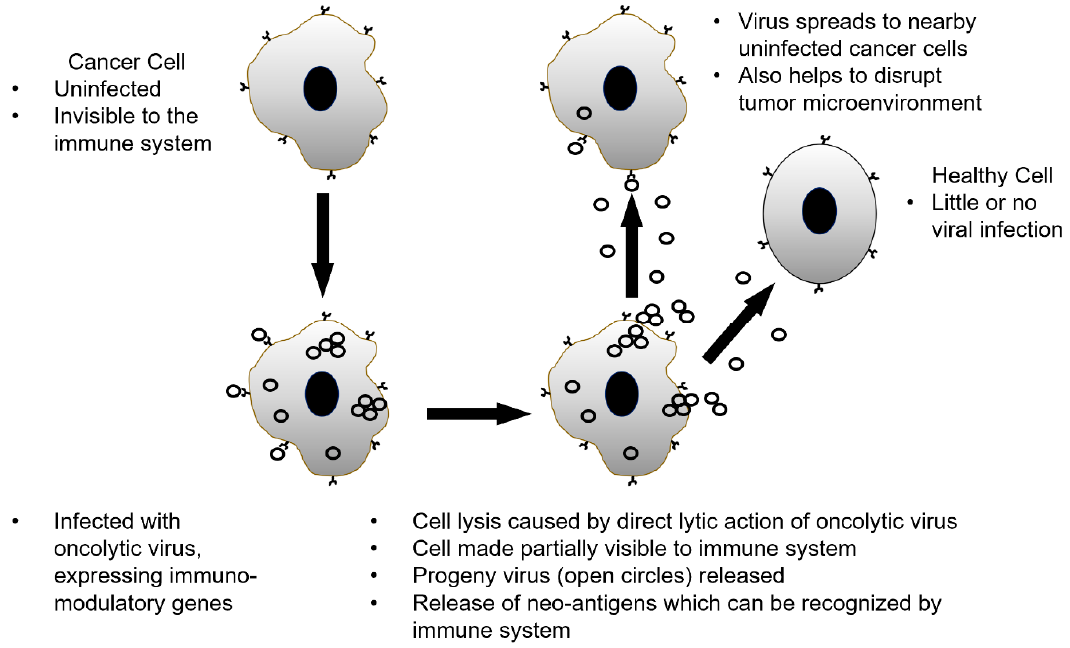
Figure 1. Simplified pathways oncolytic viruses employ to potentially regress tumors.